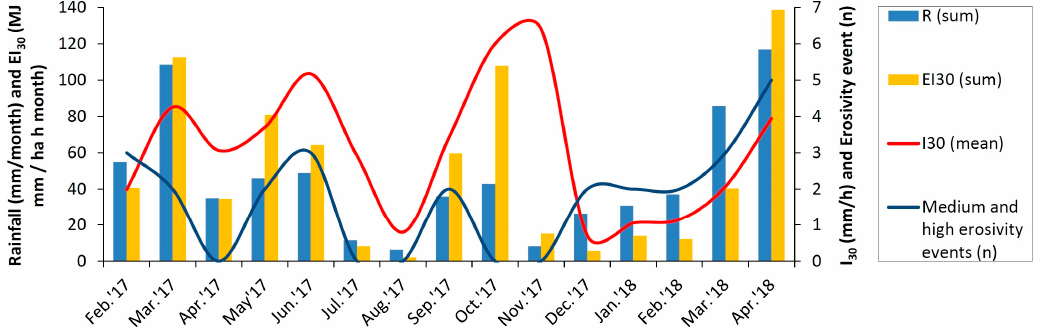
Figure 4. Monthly values of rainfall depth ( R ), maximum intensity ( I 30 ) and erosivity ( EI 30 ) and the number of medium and high rainfall erosivity events ( n ) in the synthetic weather station (Syn-WS). The values of TSWC clearly varied over the test period, with high average values ( Ɵ 0 > 20% vol.) in February 2017 and during the period December 2017–April 2018. The driest average soil conditions ( Ɵ 0 < 6.5% vol.) were observed in June and July 2017 (Figure 5). This temporal pattern was identical